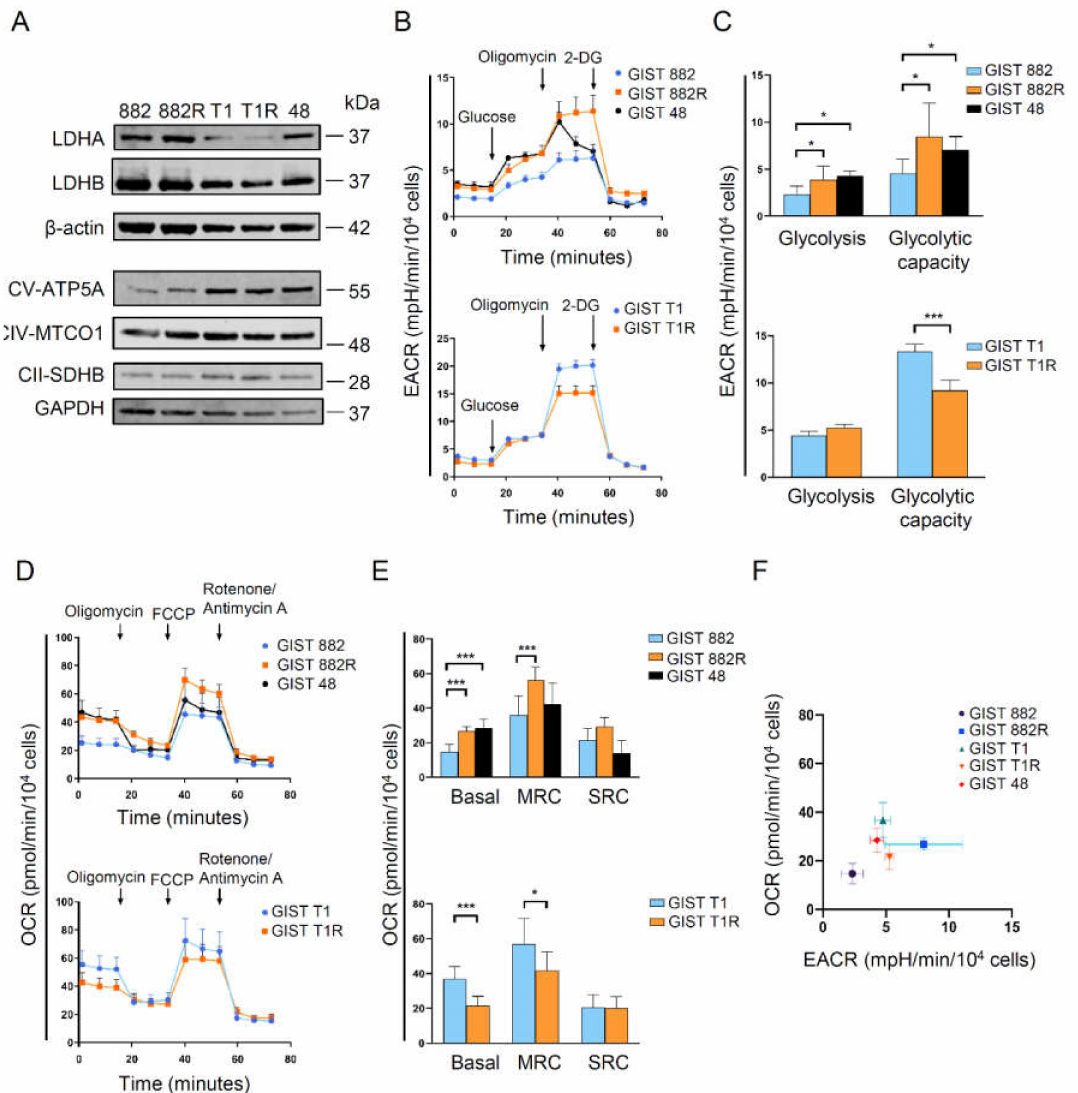
Figure 3. Bioenergetic phenotypes of imatinib-sensitive and -resistant GIST cell lines. ( A ) Basal expression levels of lactate dehydrogenases A and B (LDHA, LDHB) and OXPHOS were detected by immunoblotting. ( B ) The average extra cellular acidification rate (EACR) was measured by the glycolytic stress assay. 2-DG, 2-deoxyglucose. ( C ) The quantification of glycolysis and glycolytic capacity was analyzed by calculating the average EACR between glucose and oligomycin injection and between oligomycin and 2-DG injection, respectively. Histograms represent mean ± SD. * p < 0.05, *** p < 0.001 (Student’s t -test, n = 2). ( D ) The average oxygen consumption rate (OCR) was measured by the mitochondrial stress assay. FCCP, carbonyl cyanide-4 (trifluoromethoxy) phenylhydrazone. ( E ) Basal OCR, maximal respiratory capacity (MRC), and spare respiratory capacity (SRC) were quantified to evaluate the mitochondrial respiratory function under basal and stressed conditions. Histograms represent mean ± SD. * p < 0.05, *** p < 0.001 (Student’s t -test, n = 2) ( F ) The energy map was plotted according to the basal OCR and EACR. Data represent mean ±